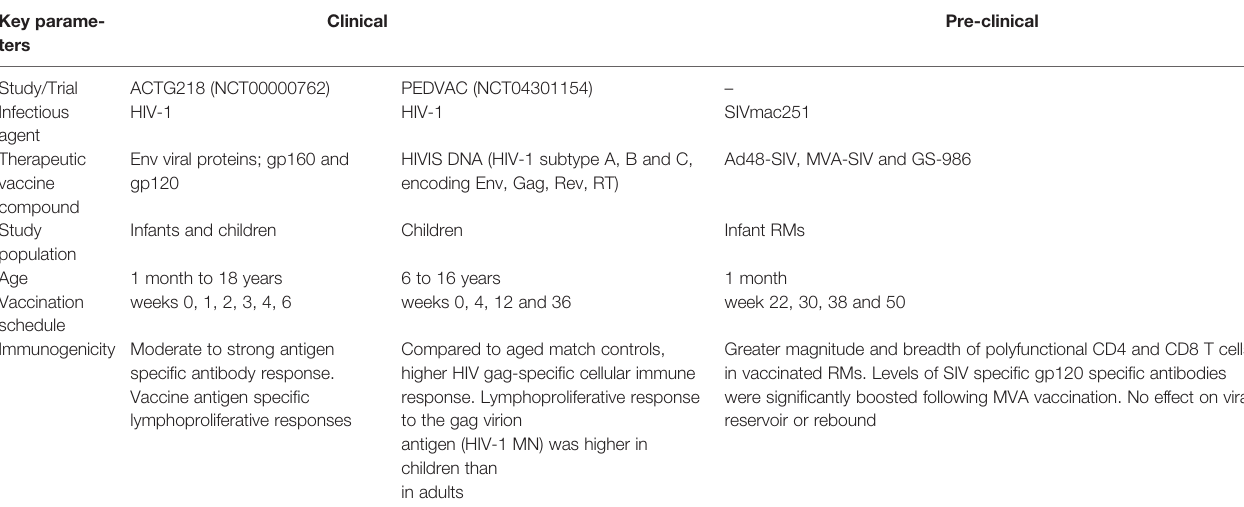
TABLE 1 | Therapeutic HIV/SIV vaccine studies for pediatric HIV